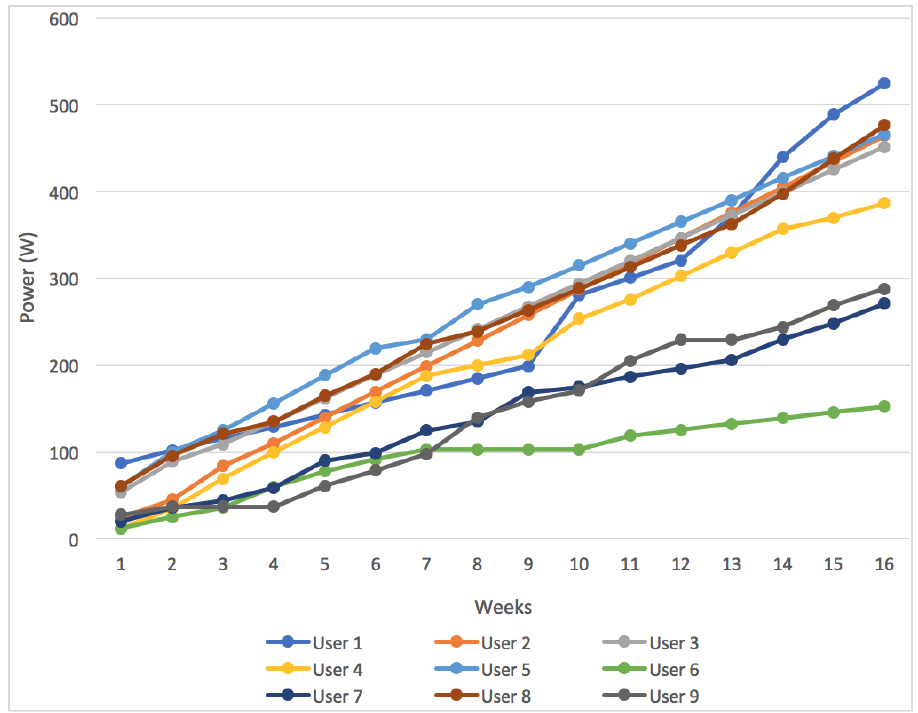
Figure 10. Results obtained by the nine case study participants.